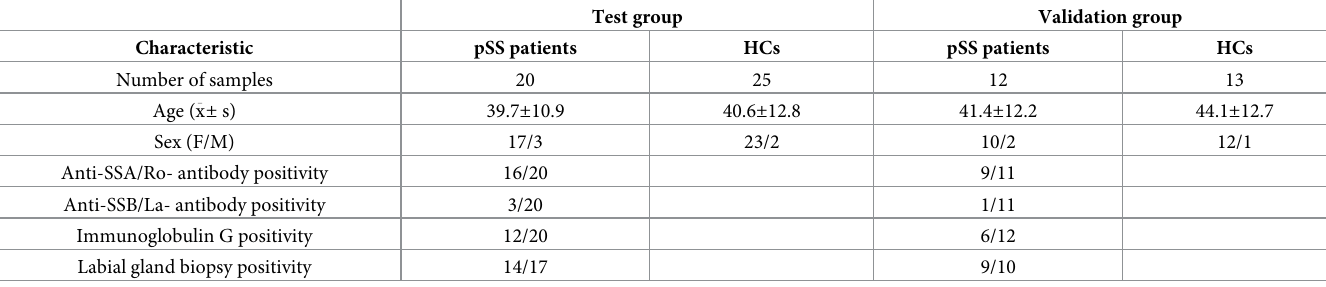
Table 1. Demographics and clinical characteristics of the pSS patients and healthy control